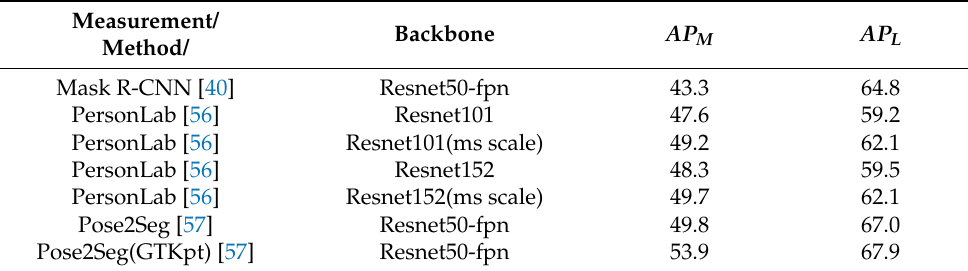
Table 3. The frame rate of human detection (fps—frames per second) on the PV 2007 benchmark dataset. AP M , AP L are the Median , Large AP categories, respectively.